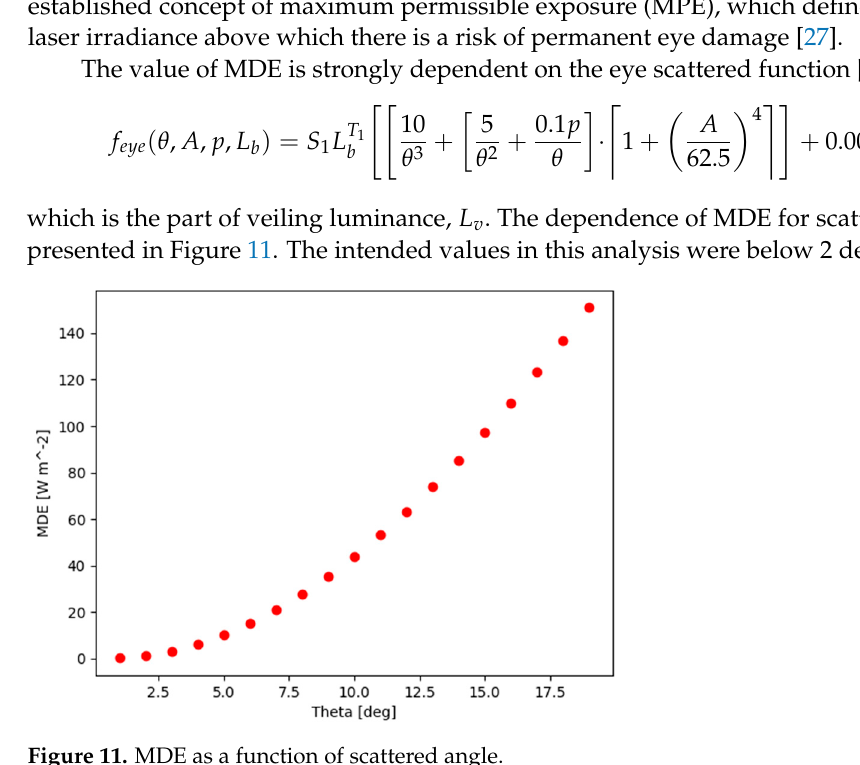
Figure 11. MDE as a function of scattered angle.